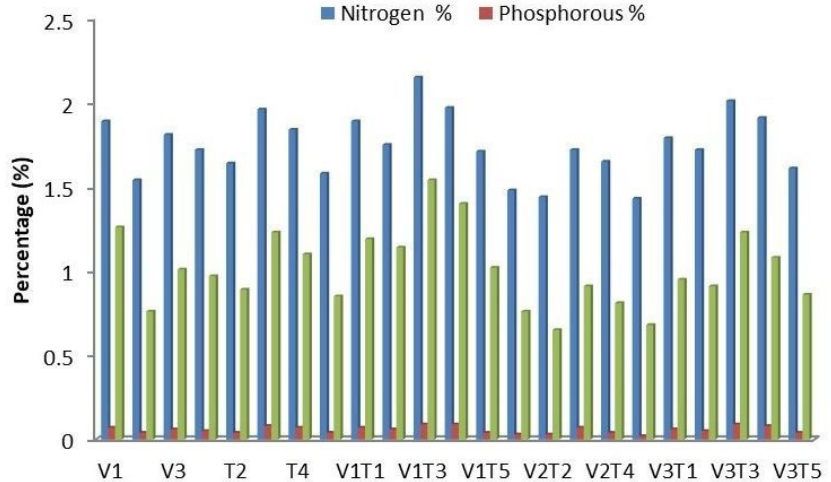
Figure 6. Response of sweet orange cultivars, time of T-budding and interactions on plant nutrient